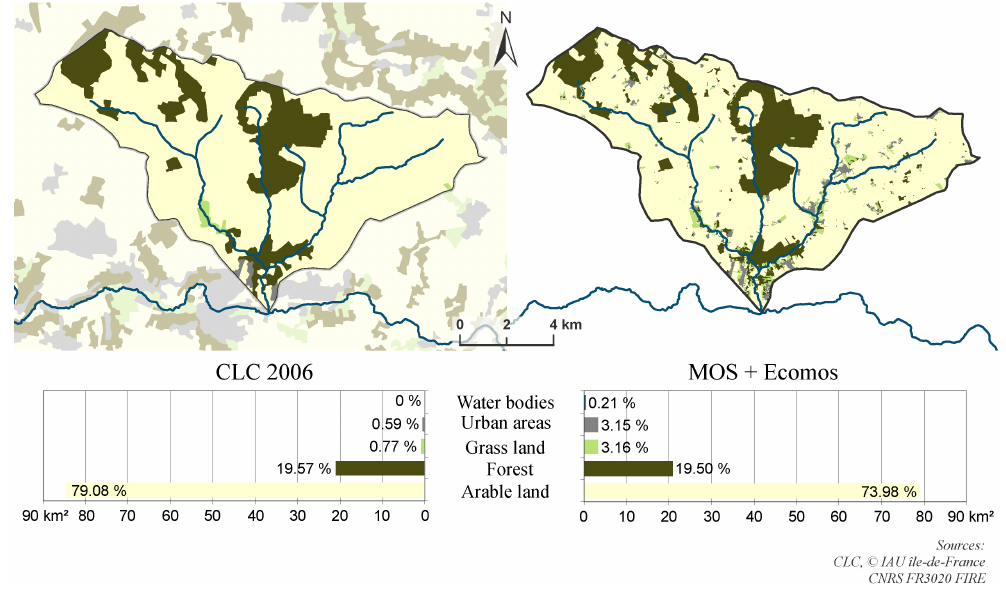
Fig. 1. Land use in the Orgeval basin in terms of forest, grassland and cropland. Urban areas are shaded grey. The drainage network is also